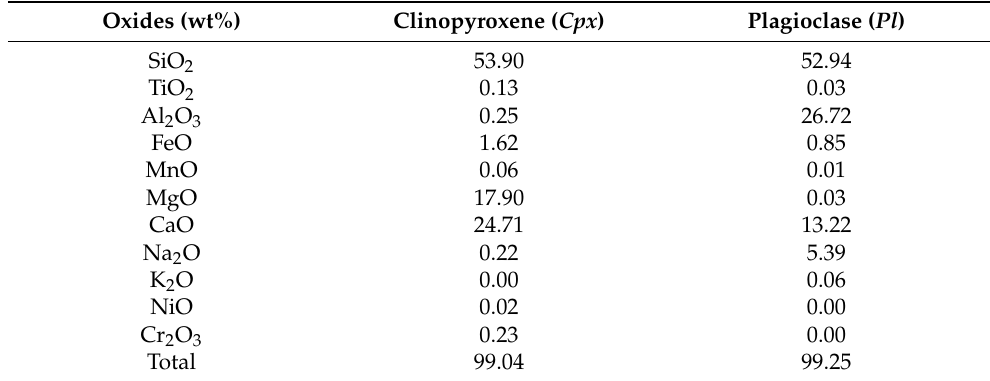
Table 1. The chemical composition of the main constituent minerals in the hot-pressed sintering gabbro by virtue of the electron microprobe